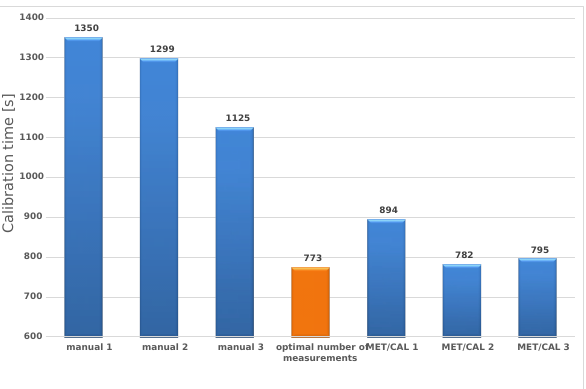
Figure 9. The result of optimization calculations with three methods for the point 40 V